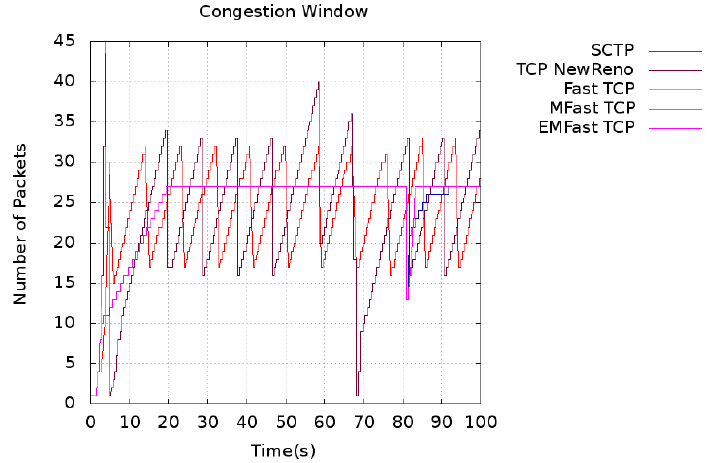
Figure 7. Congestion window graph, with four competing flows during the simulation period.